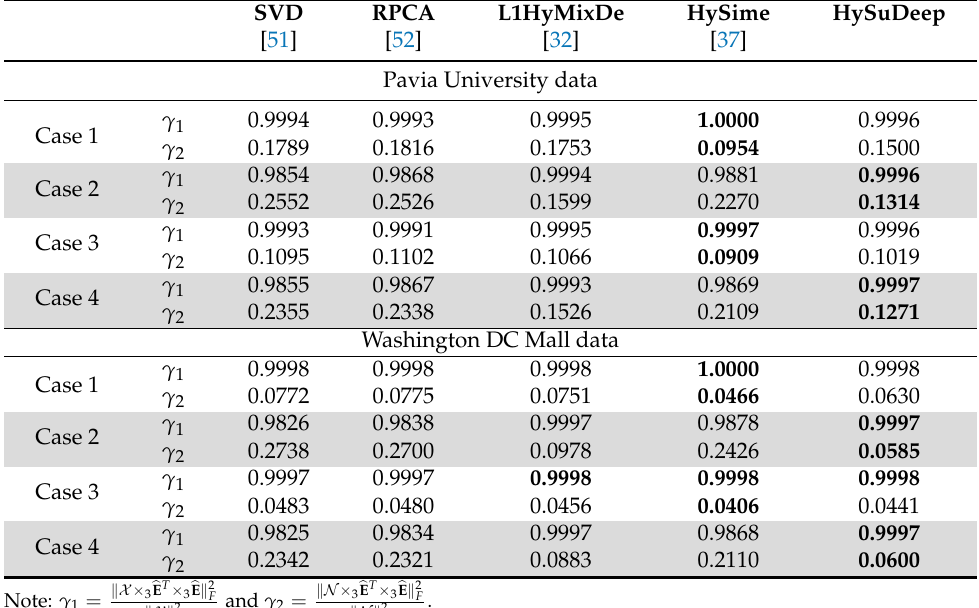
Table 4. Quantitative comparison of representation ability of subspaces learned by different methods.